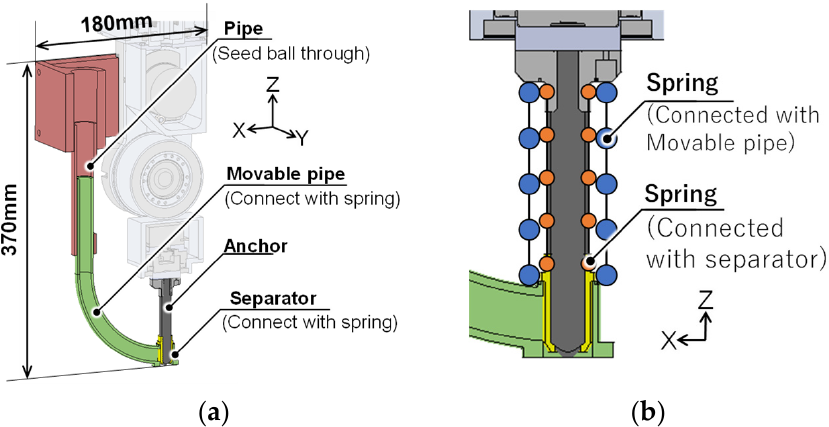
Figure 10. ( a ) a bell pepper seed and a seed ball, ( b ) CAD of a tank. A seed ball and a tank.